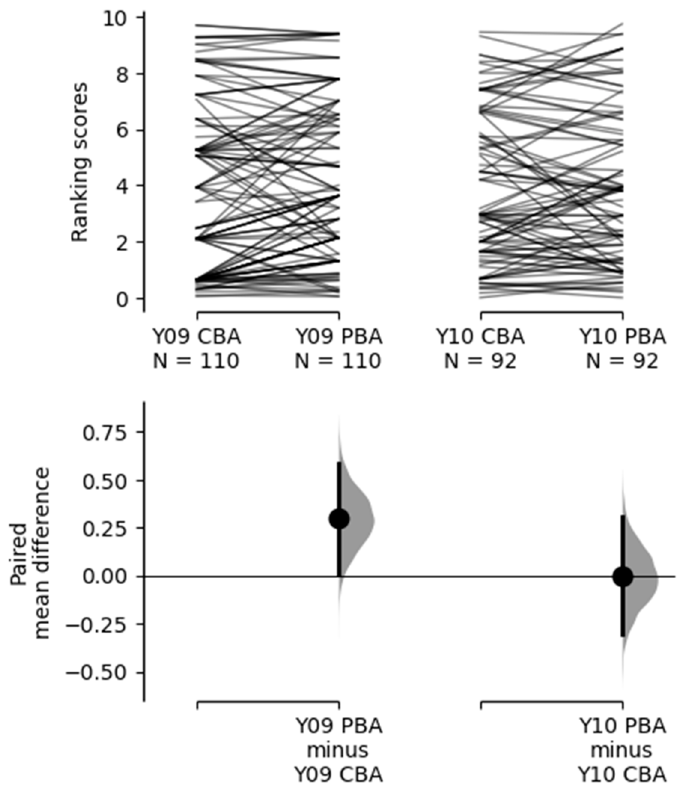
Figure 4. Gardner–Altman estimation plot for the paired mean difference between PBA and CBA scores of 110 pupils (cohort Y09) and 92 pupils (cohort Y10).